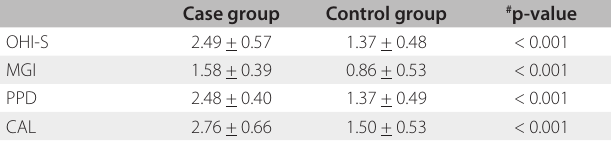
Table 4. Mean values for periodontal parameters in both groups Case